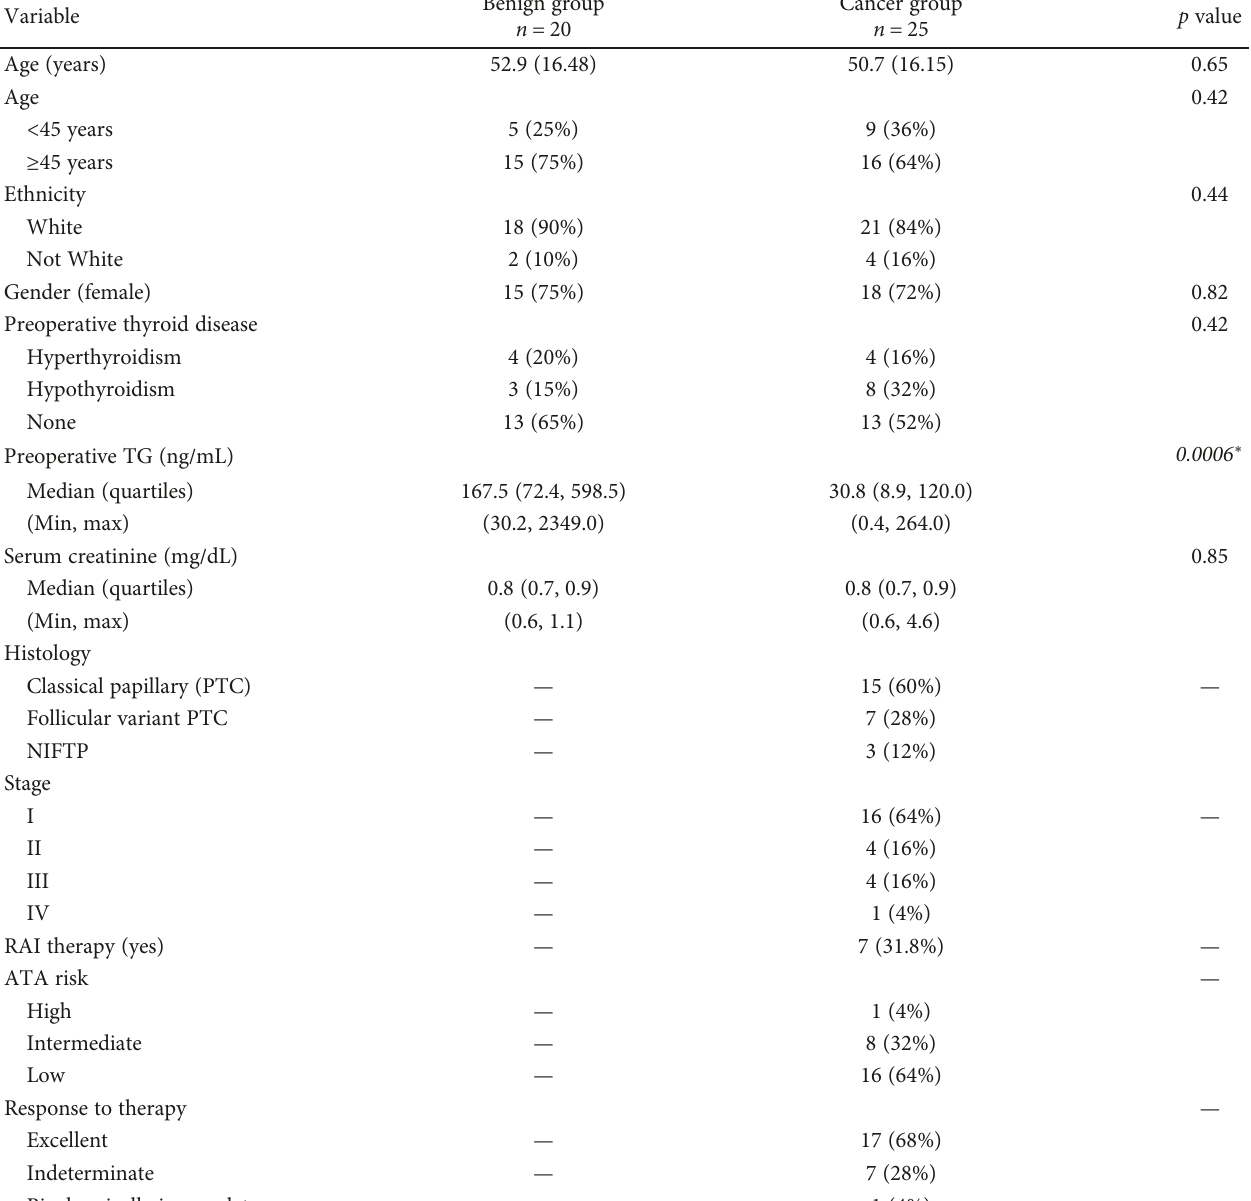
Table 1: Baseline